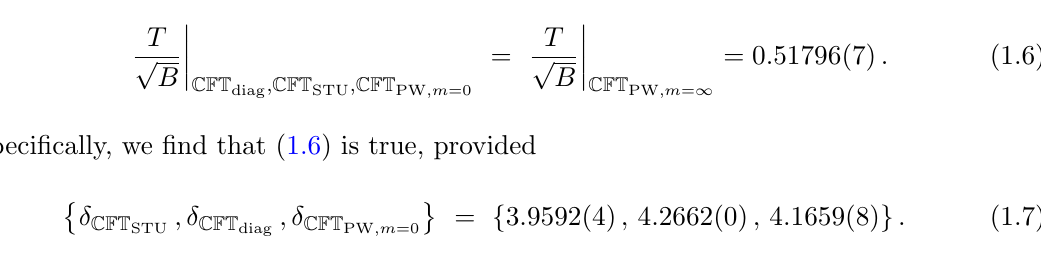
Figure 1 . Anisotropy parameter R = P T =P L for conformal models CFT diag (black curves), CFT STU (blue curves), CFT PW ;m =0 (green curves) and CFT PW ;m = 1 (red curves) as a function of T= R CFT is renormalization scheme independent; for the other models there is a strong depen- PW ;m = 1 dence on the renormalization scale (cid:14) = ln B : di(cid:11)erent panels represent di(cid:11)erent choices for (cid:14) ; (cid:22) 2 all the models in the same panel have the same value of (cid:14) , leading to identical high-temperature p asymptotics, T= B (cid:29)